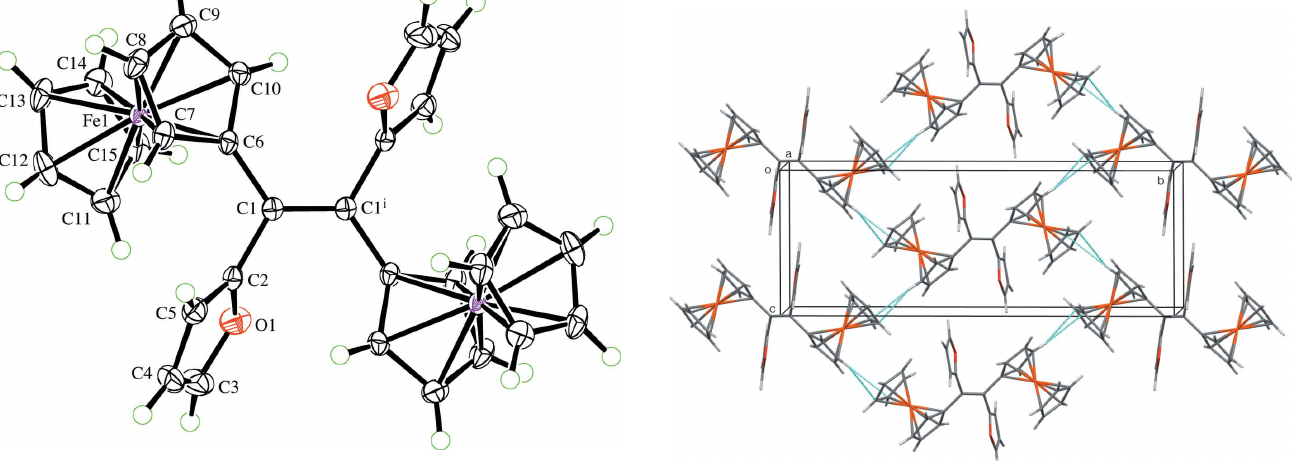
Figure 1 The molecular structure of the title compound, ( E )- 1 , showing the atom- numbering scheme. Displacement ellipsoids are drawn at the 50% probability level. Symmetry code: (i) (cid:4) x + 1, (cid:4) y + 1, (cid:4) z +